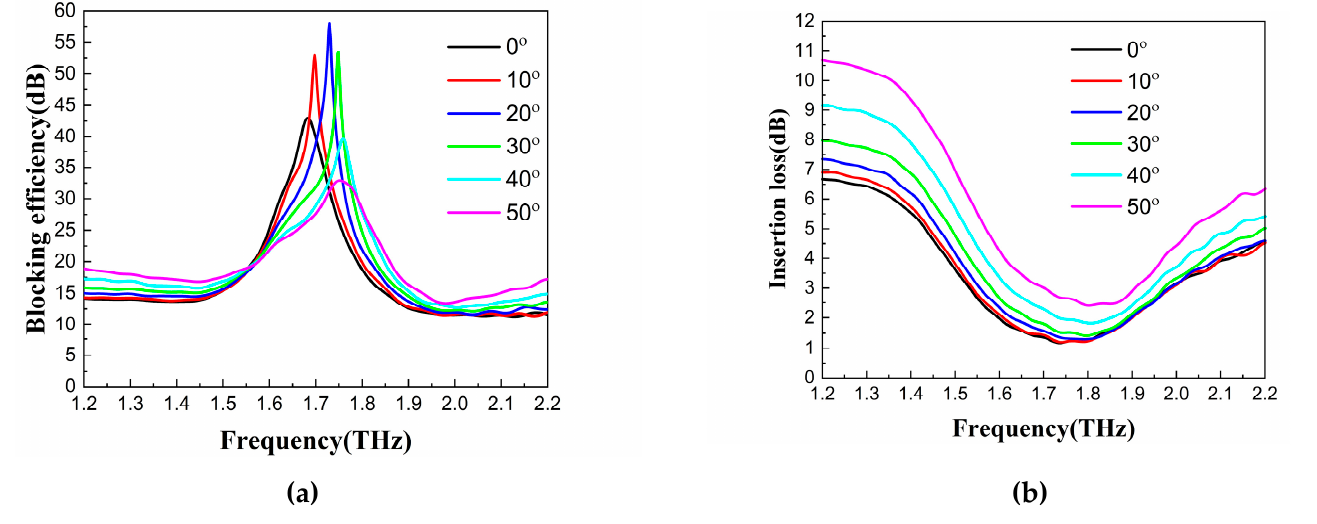
Figure 7. ( a ) Measured blocking efficiency curves and ( b ) insertion loss curves of this blocking device at different incidence angles.